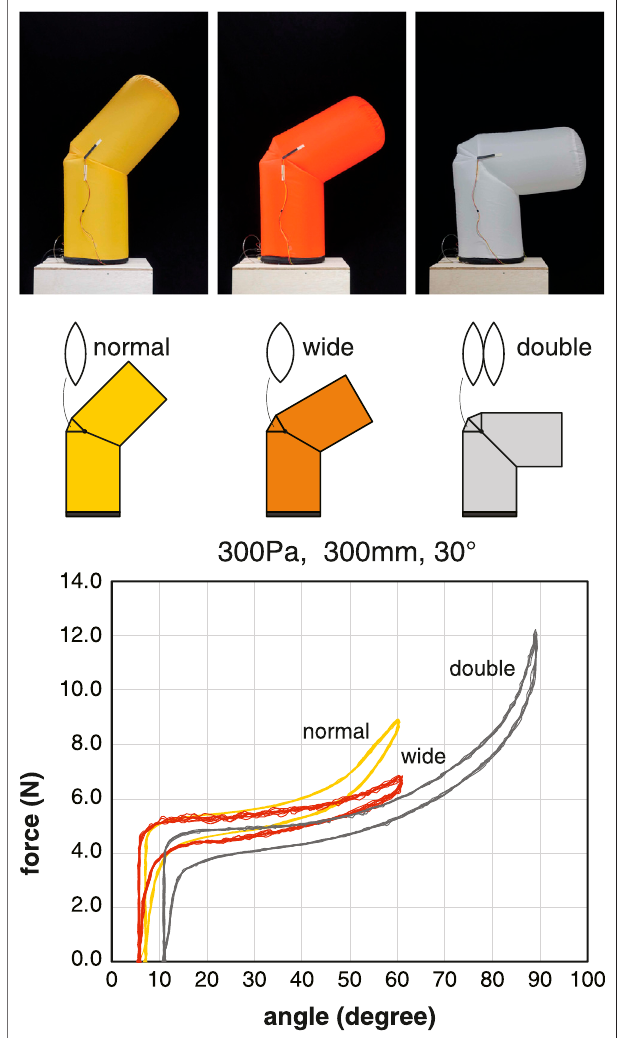
FIGURE 8 | Comparison of the tension-angle relationship for different types of leaf-shaped patches. The in fl atables used for the measurement were U300, U300W, and U300D. Plots of 10 cycles at the pressure condition of